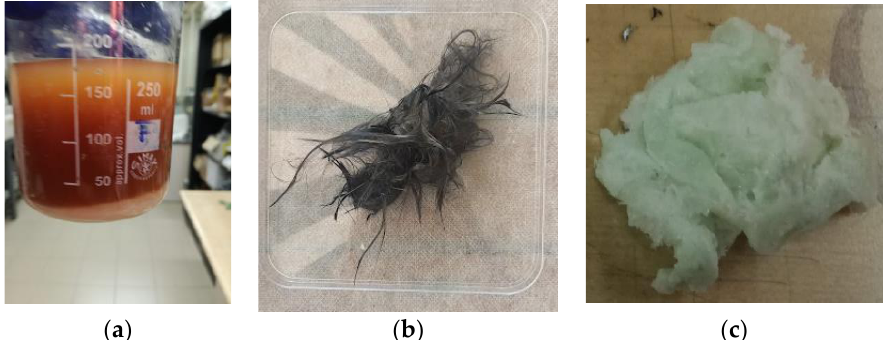
Figure 2. Products obtained from composite recycling: ( a ) epoxidized waste flour (EWF), ( b ) carbon fibers, and ( c ) Polar Bear TM epoxy.